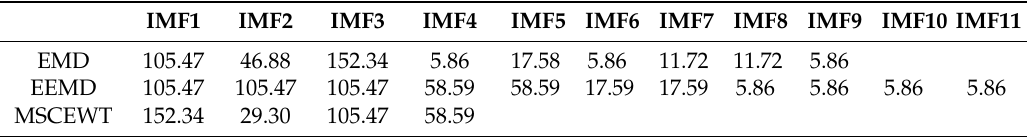
Table 7. The experimental results of the outer race of the motor bearing.